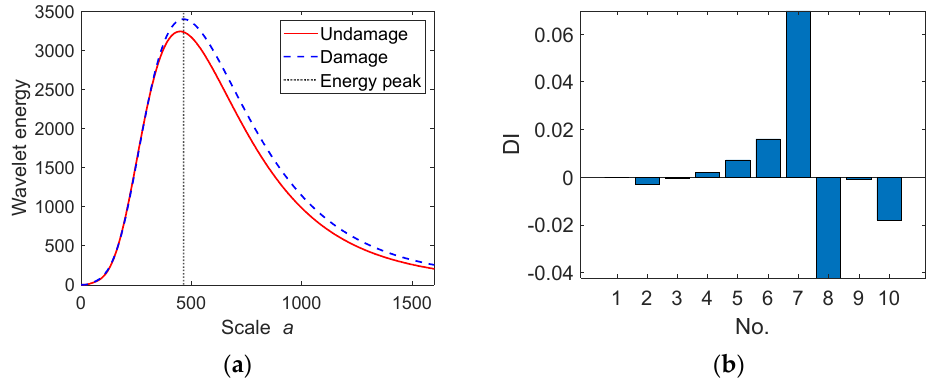
Figure 17. Bridge damage identification with noise signal. ( a ) wavelet energy; ( b ) damage index.